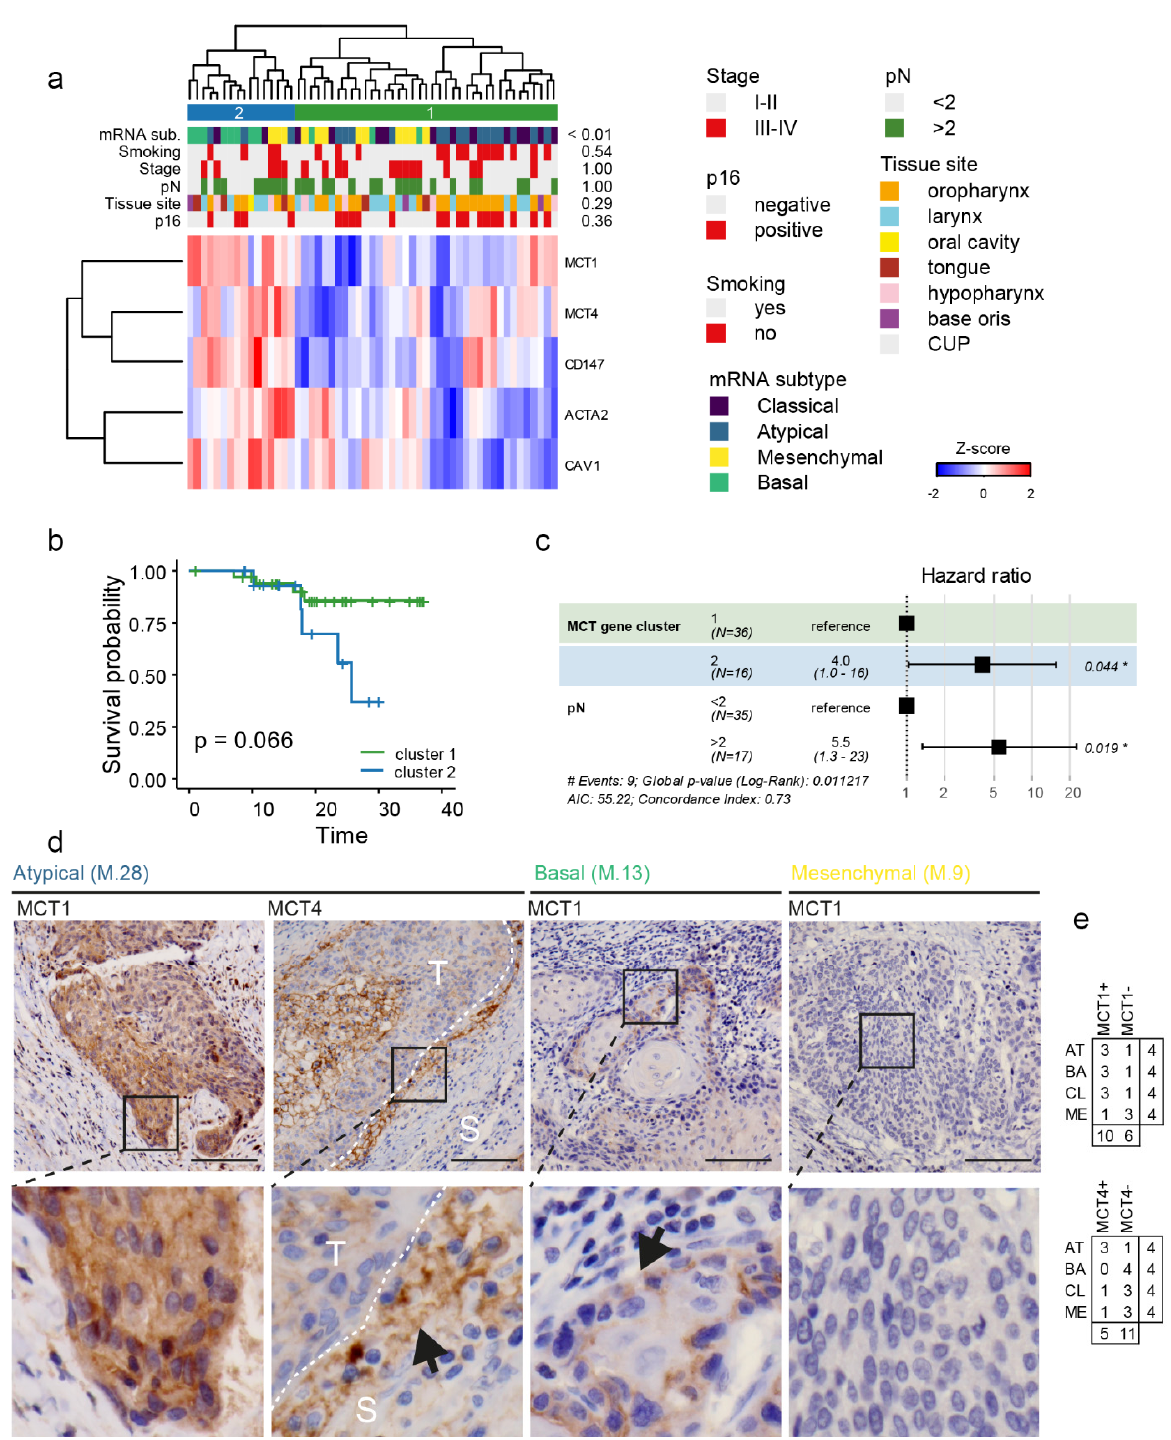
Figure 5. Lactate shuttle-relevant gene expression clusters in tumour tissues are associated with patient survival. ( a ) heatmap of tumour tissue lactate shuttle-relevant gene expression in 55 primary head